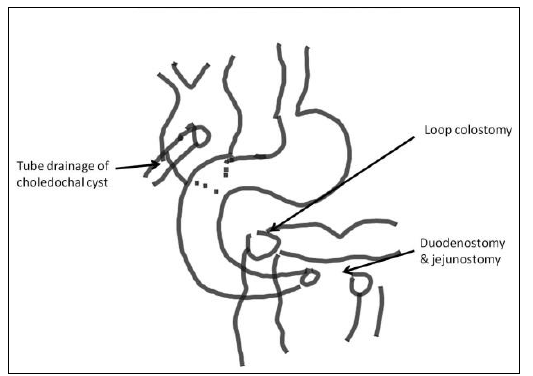
Figure 3: Surgical procedure: external drainage of chole- dochal cyst with duodenostomy and jejunostomy and loop